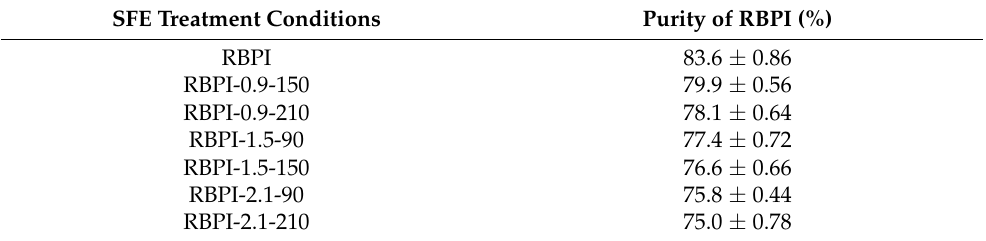
Table 5. Purity of RBPI under different SFE conditions